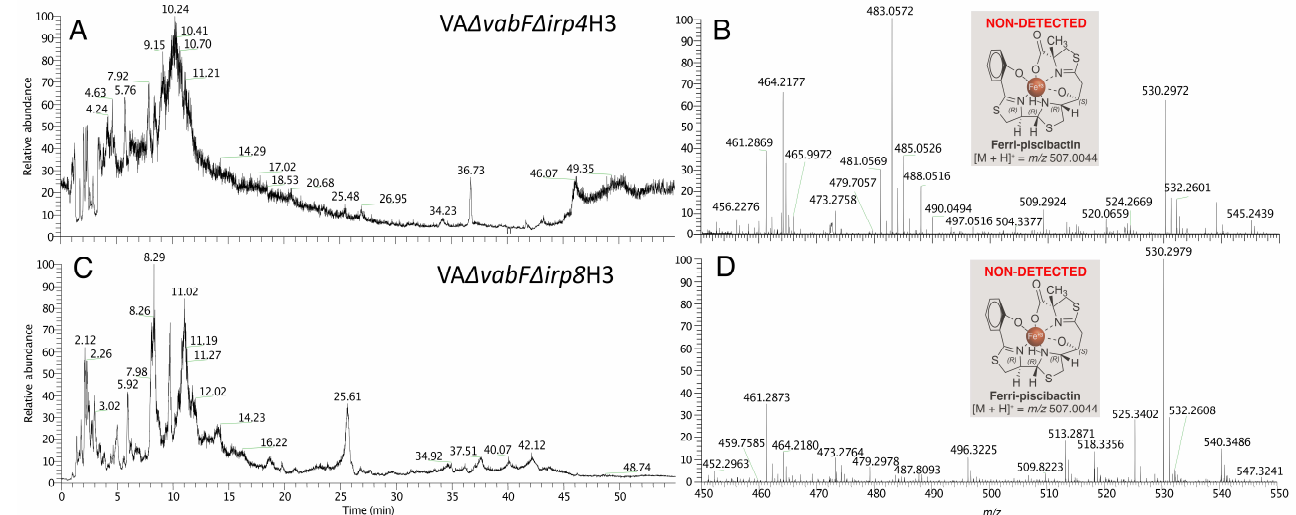
Figure 4. ( A ) HPLC/HRMS analysis of VA∆vabF∆irp4H3 and VA∆vabF∆irp8H3 fractions, eluted